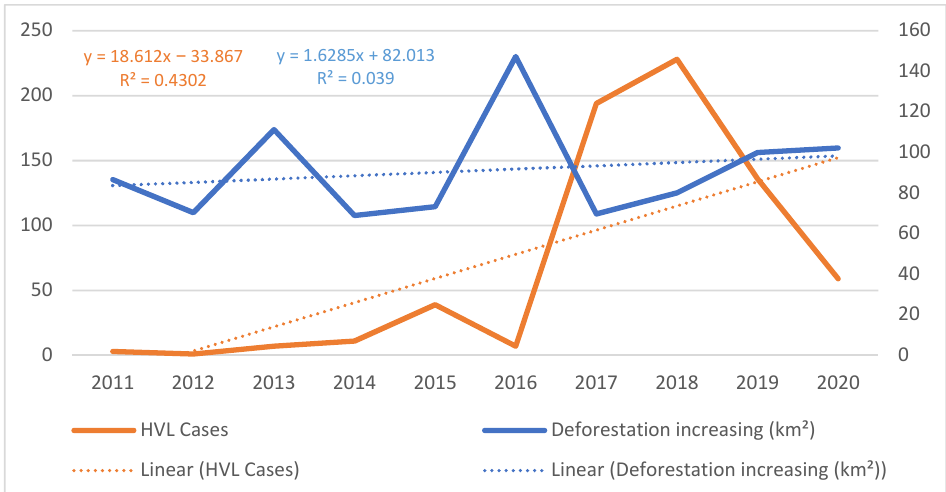
Figure 4. Spatial distribution of human visceral leishmaniasis cases, land use and cover, and interpretation of the Moran’s Index (I) spatial autocorrelation in the Carajás Integration Region, Pará, Brazil, for the period of 2011 to 2020.